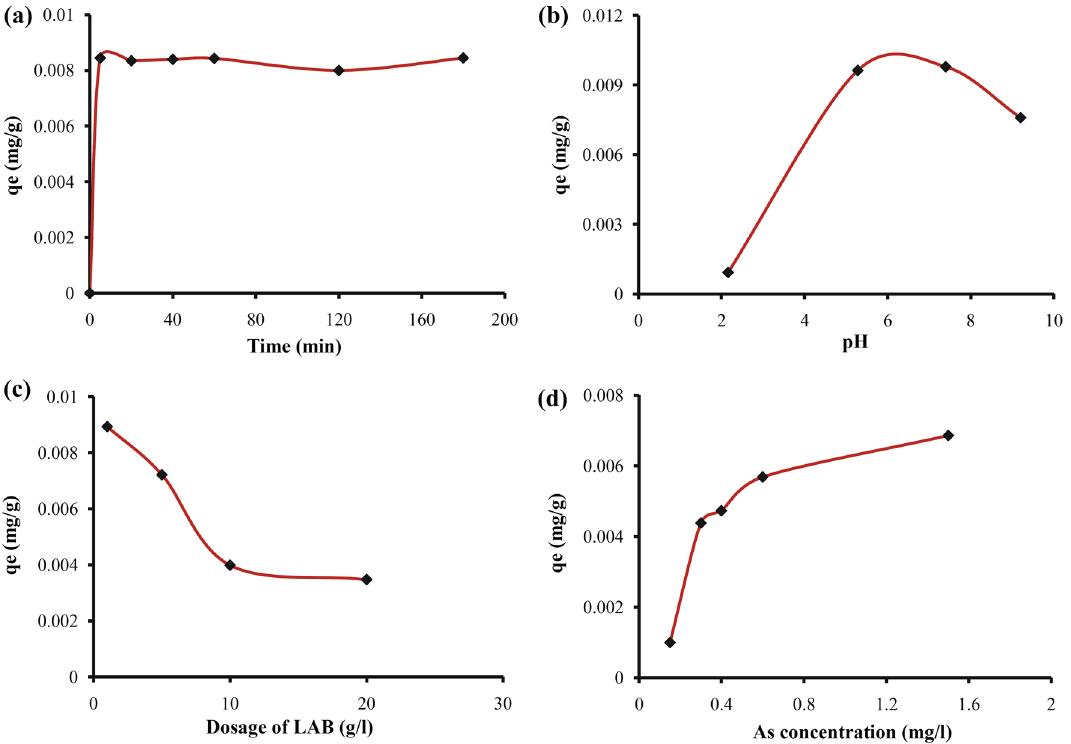
Fig. 3 Effects of contact time (C0: 0.3 mg/L, pH: 7.4, M: 5.0 g/L), initial pH (T: 10 min, C0: 0.3 mg/L, M: 5.0 g/L), dosage of HS12 biomass (T: 10 min, pH: 7.4, C0: 0.3 mg/L) and initial concentration (T: 10 min, pH: 7.4, C0: 0.5 g/L) on the As biosorption of HS12